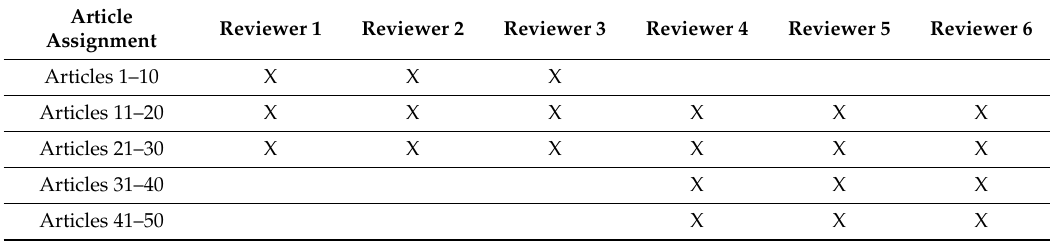
Table 1. Reviewer assignment of the initial database search findings (full article review) .